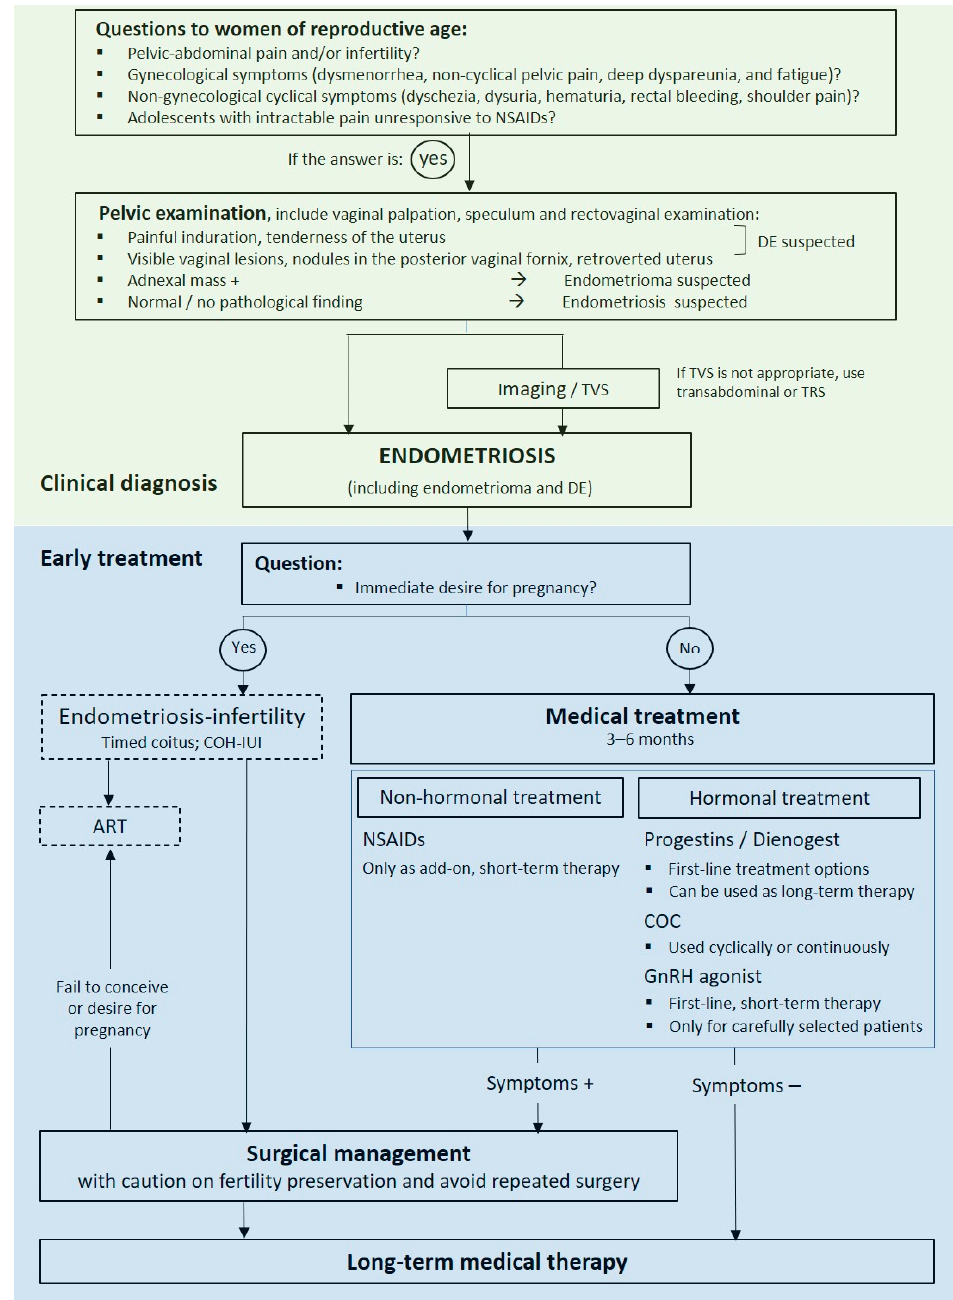
Figure 1. Algorithm for the clinical diagnosis and early treatment of endometriosis in Asia. ART, assisted reproductive technology; COC, combined oral contraceptive; COH, controlled ovarian hyperstimulation; DE, deep endometriosis; GnRH, gonadotropin-releasing hormone; IUI, intra-uterine insemination; NSAID, nonsteroidal anti-inflammatory drug; TRS, transrectal sonograph; TVS, transvaginal sonography.